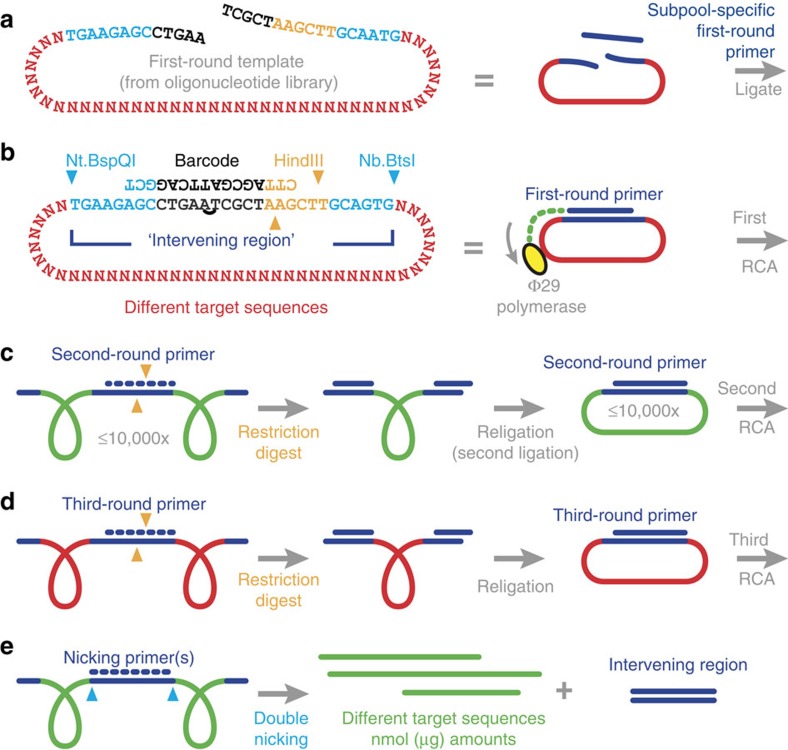
Oligonucleotide amplification by circle-to-circle amplification.(a) Subpool-specific first-round primers determine which subpool is amplified in the respective well of the 96-well plate (as in Fig. 1c). Primers are orthogonal and complementary to only one subpool-specific barcode set of the library and parts of the common sequence (details in Supplementary Note 2) and therefore only hybridize to the strands of the respective subpool and do not bind to template strands of other subpools. The targeted template strands are cyclized via ligation into circular template strands. (b) A polymerase with high processivity and strand displacement capacity is added (Phi29, yellow). Initiating at the first-round primer, the polymerase synthesizes concatenated (chain-like) repeated copies of the circular template (green is complementary to red). Non-circularized template strands of other subpools are not amplified. Under optimal conditions, we observed up to 10,000 concatenated copies of each template molecule for one RCA (quantitative real-time PCR experiments, data not shown). However, this amplification rate by itself is not sufficient for most applications, as each library contains only attomoles (10−18 moles) per oligonucleotide sequence and only a small aliquot (for example, 1/1,000) of the library is used as a template for each amplification. (c) A second-round primer (blue dotted line) is hybridized to the intervening region of the first concatemer and the resulting double-stranded recognition site (orange) is digested with a restriction enzyme (HindIII) into monomers. A heat-inactivation step is necessary to inactivate the restriction enzyme for the next steps and is performed after most of the enzymatic reactions (details in Methods). The cut fragments of the second-round primer dissociate during this step. On cooling, an excess of the second-round primer hybridizes to the cut monomeric units and colocalizes the ends for a second ligation and RCA step. This second circular template has the reverse complementary sequence of the first circular template. (d) A third-round primer is annealed to the second concatemer (red again). Restriction digest, re-ligation and RCA are repeated to yield the final concatemer (e). One or two nicking primers are hybridized to this concatemer. A double-nicking reaction excises the intervening region from the target sequences (green). The nicking enzymes cut outside of their recognition sites; therefore, the entire intervening sequence can be removed to yield the (green) sequences of interest of a given subpool. Until this point, the entire process can be performed as a one-pot reaction without any intermediary workup steps. The excess of nicking primers, the intervening sequences, residual undigested concatemers and the excess of primers and enzymes can be removed using a final anion exchange chromatography step (see Methods).